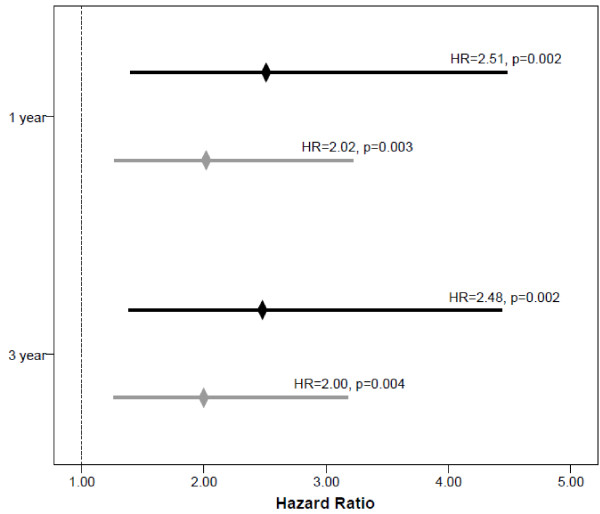
Adjusted hazard ratios (HR) of categories of the apo A1 remnant ratio (apo A1/ [VLDL3-C+IDL-C]) at 1 year and 3 year death/MI.